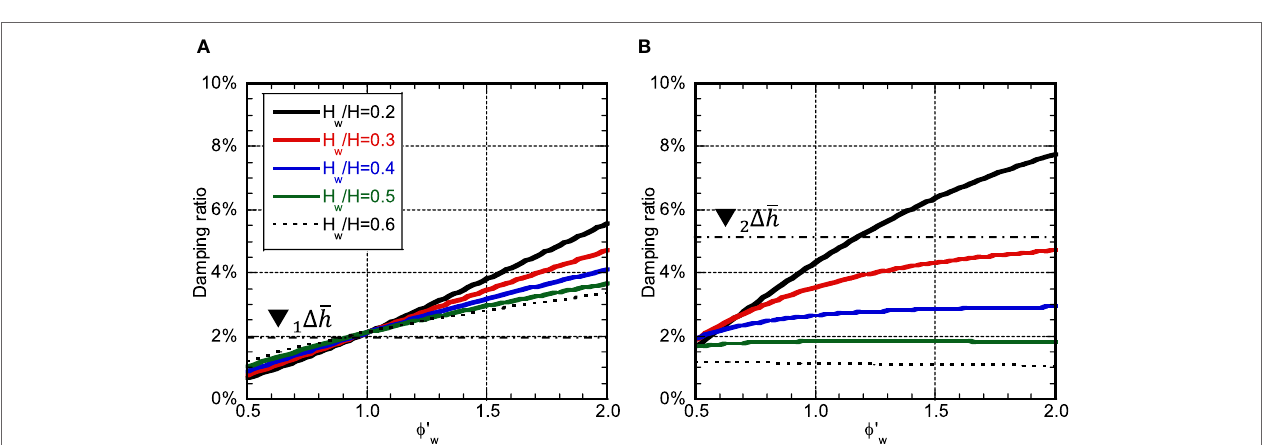
FIGURE 6 | Damping ratio with respect to Φ ′ w : (A) first mode and (B) second mode.